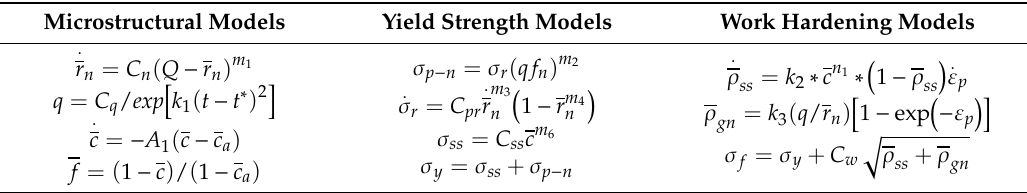
Table 1. Summary of the constitutive model for ageing of